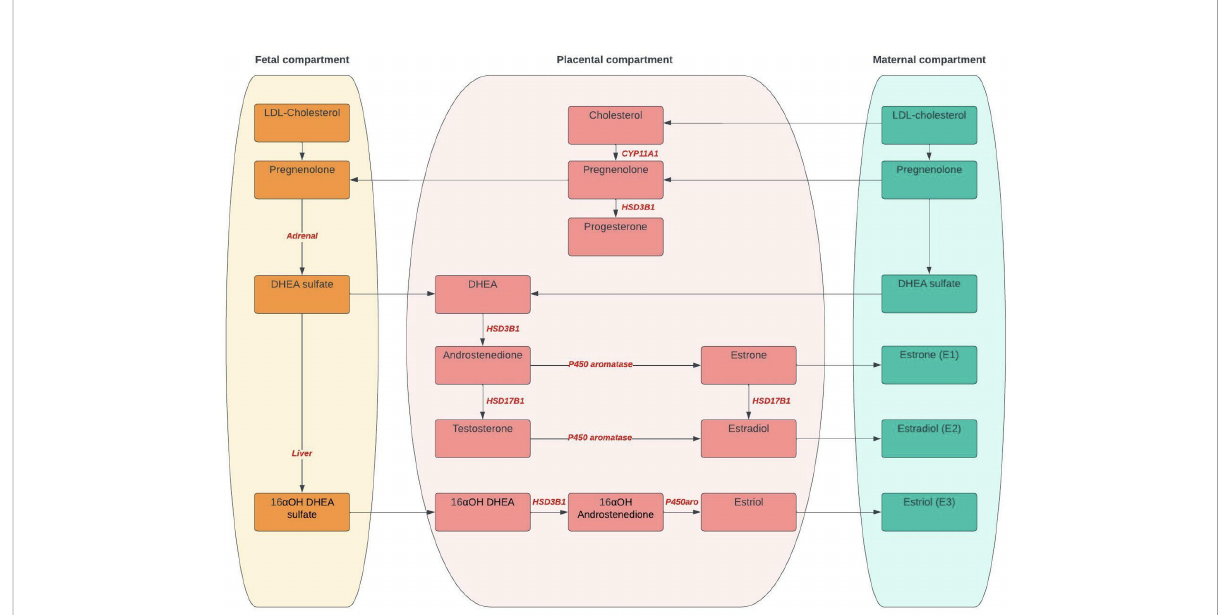
FIGURE 1 Steroid synthesis during pregnancy. CYP11A1, Cytochrome P450 side-change cleavage enzyme; HSD3B1, 3 b - hydroxysteroid dehydrogenase 1; HSD17B1, 17- b - HSD type 1; DHEA, Dehydroepiandrosterone; 16 a OH; 16 a